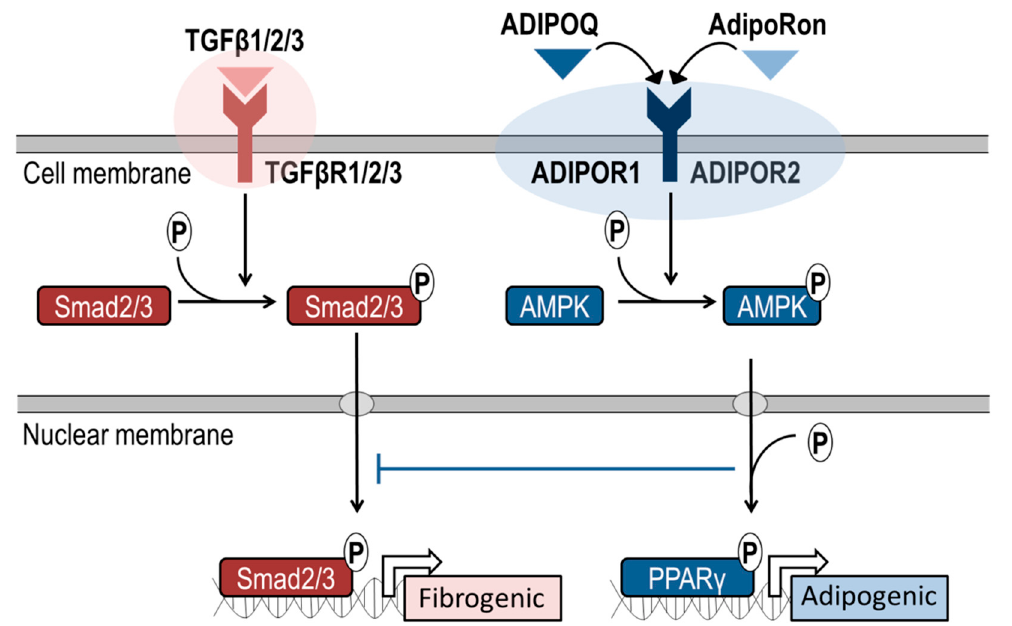
Figure 8. Model depicting pharmacologic modulation of adipogenic pathways for treatment of arthrofibrosis. Schematic showing intra-cellular signaling cascades of TGF β mediated pro-fibrotic pathways and proposed ADIPOR1- and ADIPOR2-related pathways that inhibit TGF β dependent molecular pathways. Canonical TGF β signaling is characterized by a SMAD2/3 initiated cascade leading to inflammation and extracellular matrix production. Parallel activation of the ADIPOR1 and/or ADIPOR2 pathways (blue box) by AdipoRon or ADIPOQ results in downregulation of inflammatory transcription factors and upregulation of PPAR γ —a primary transcription factor regulating adipogenic differentiation.